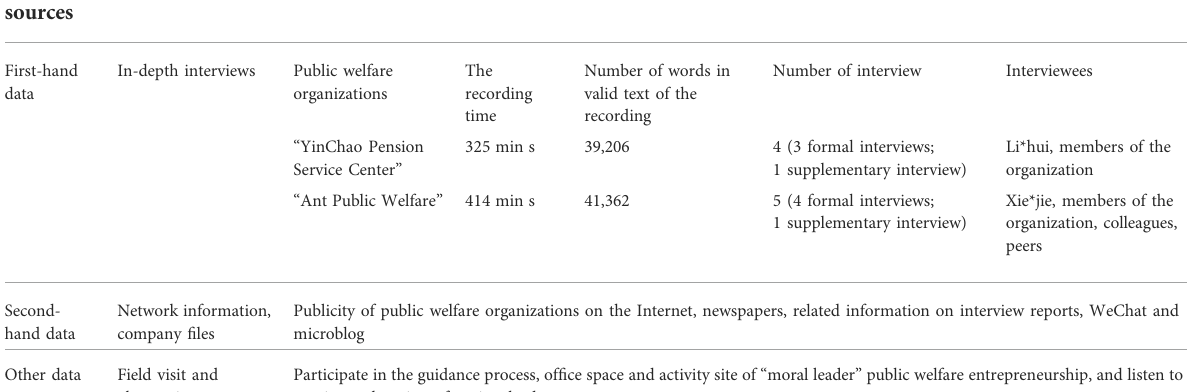
TABLE 1 “ Moral leaders ” and their organizational data